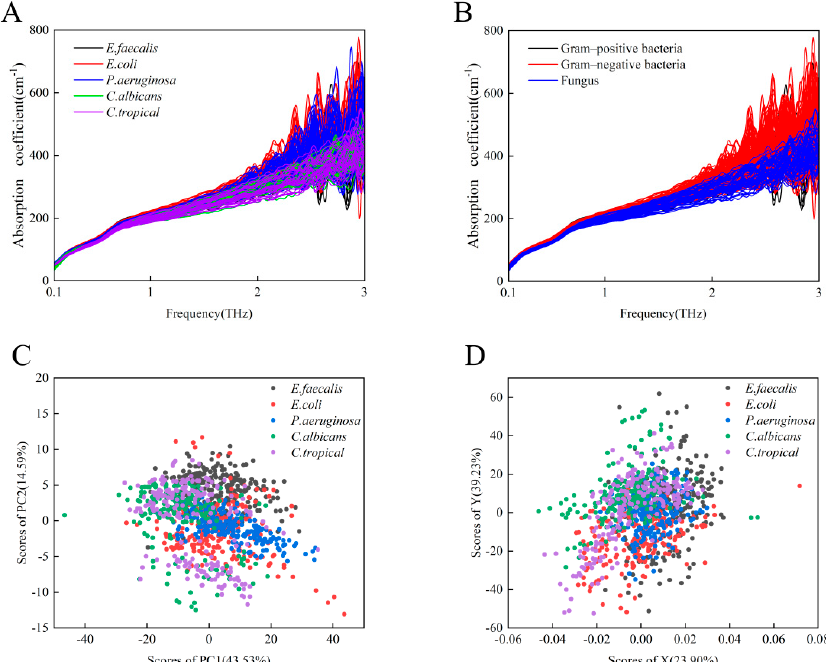
Figure 3. ( A ) A total of 1123 THz absorption spectra curves of 5 species of clinical strains, specifically E. faecalis (black), E. coli (red), P. aeruginosa (blue), C. albicans (green), and C. tropicalis (purple). ( B ) THz absorption spectra of one Gram-positive bacterial strain (black), two Gram-negative bacterial strains (red), and two fungi (blue). ( C ) PCA representation of the THz spectra for the above five clinical strains. ( D ) Least-squares analysis representation of the THz spectra for the above five clinical strains.